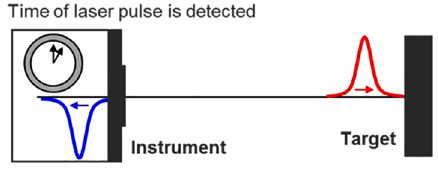
Figure 1. Time of flight technology (Maar & Zogg,